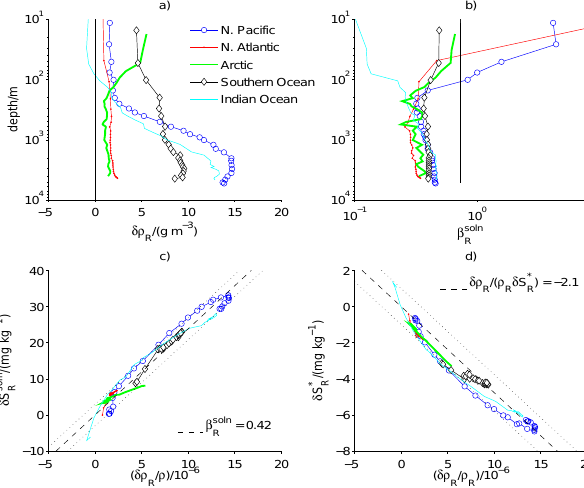
Fig. 7. (a) δρ R calculated for the hydrographic profiles described in Fig. 6. (b) β soln for these profiles. (c) A comparison between R model δS soln and the normalized density anomaly δρ R /ρ . Dotted R lines show a salinity uncertainty of ± 3 mg kg − 1 above and below the line. (d) A comparison between model δS ∗ and δρ R /ρ . Dotted R line shows an uncertainty of ± 1 mg kg − 1